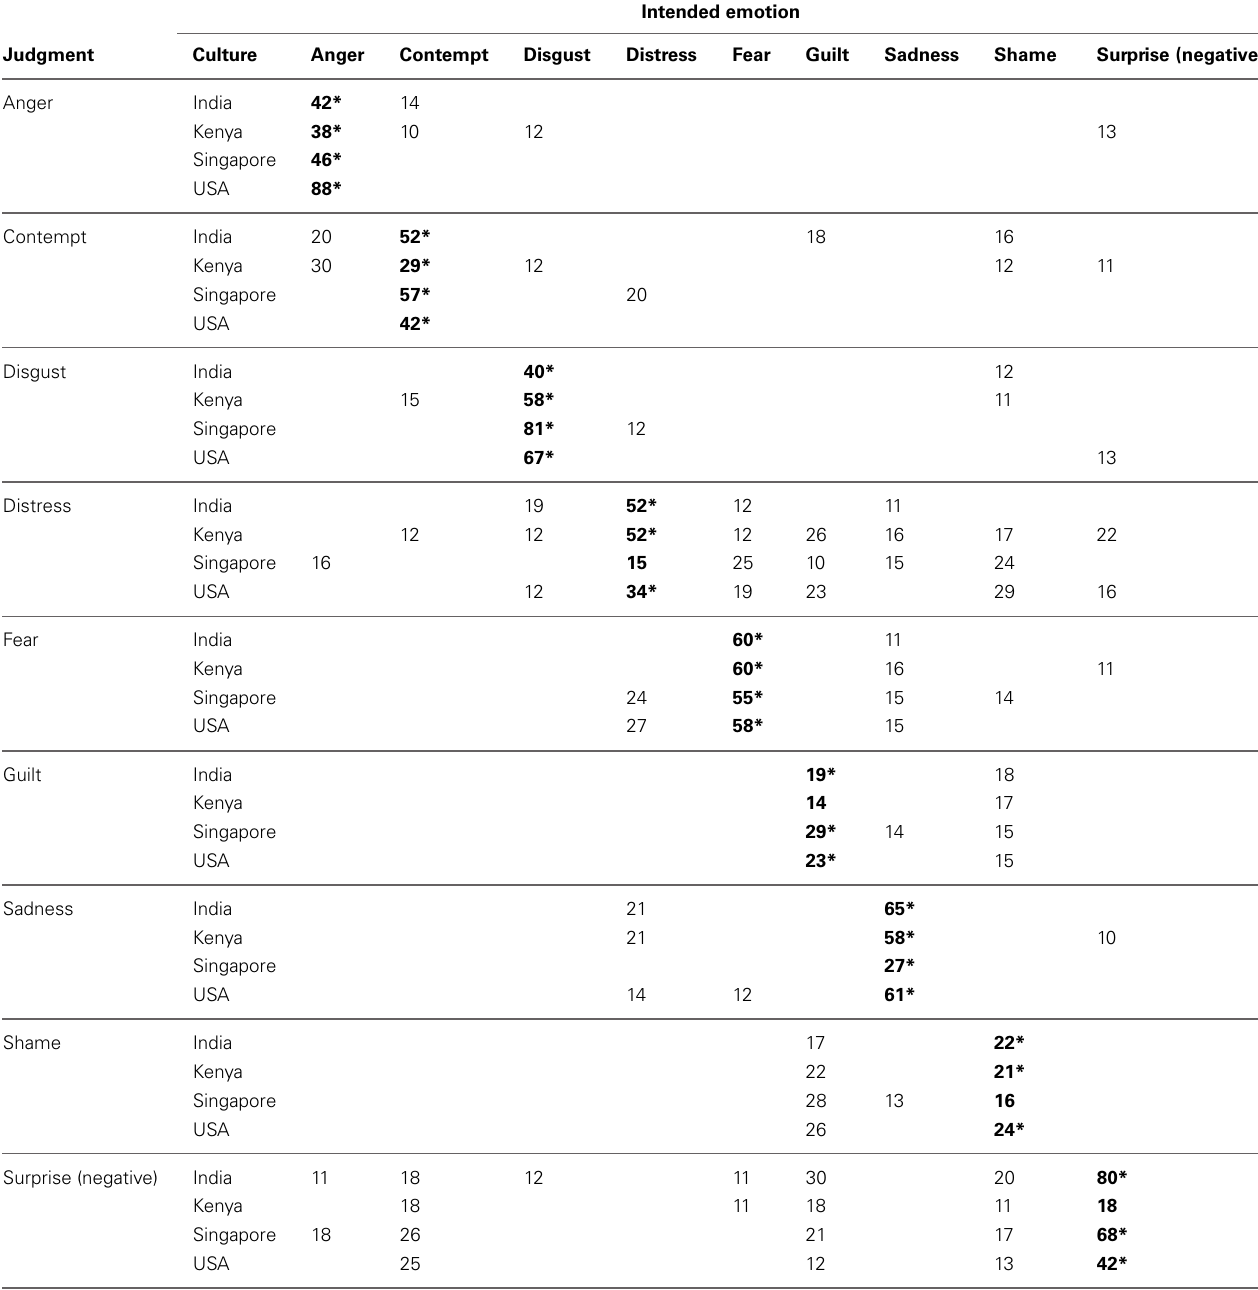
Table 3 | Recognition rates and confusion patterns for non-linguistic vocalizations of nine negative emotions from four